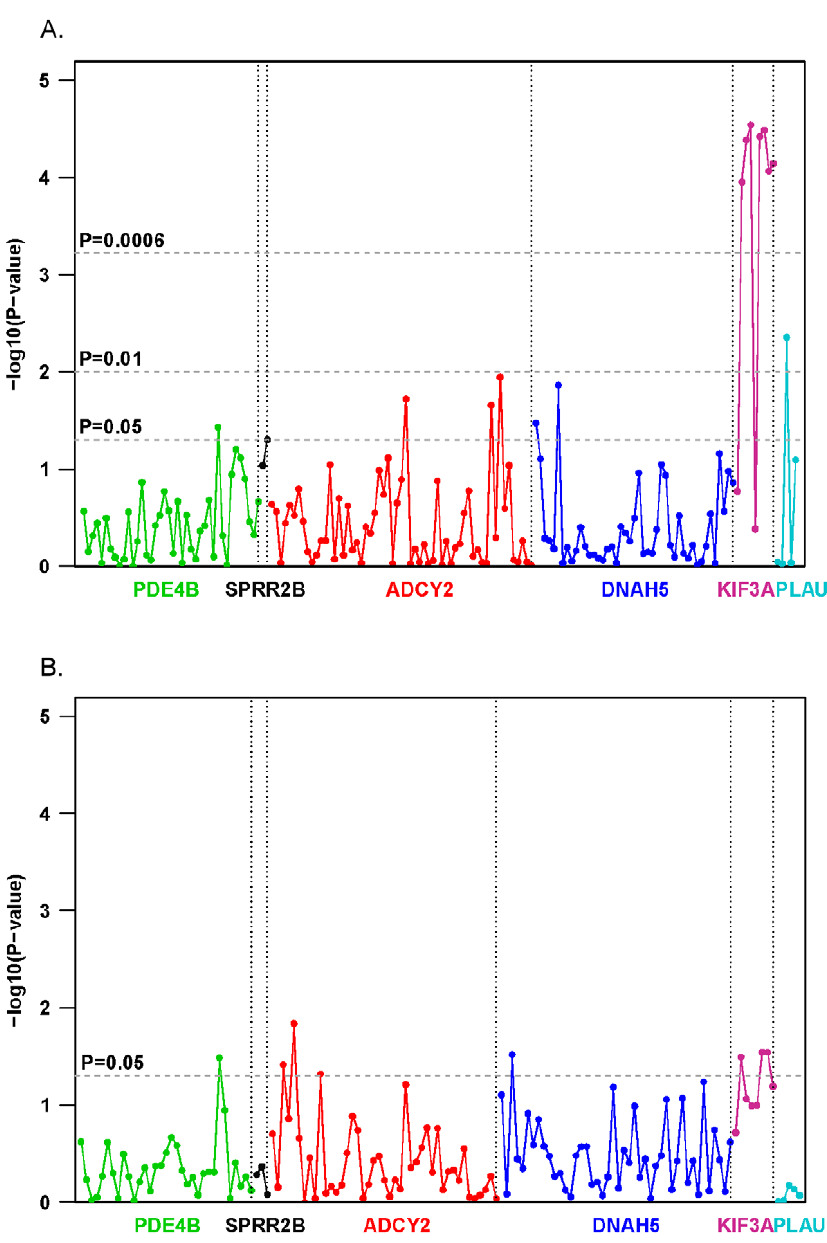
Figure 2. Genetic associations with childhood asthma. A . We evaluated associations in our discovery Caucasian population between asthma and 160 directly genotyped SNPs within the six epithelial genes using the additive model after adjusting for age and gender. The upper dashed line corresponds to a p-value of 0.0006, the Bonferroni adjustment after considering LD correlation between SNPs. SNPs significant at this level (all in KIF3A ) include rs12186803 (p=0.00011), rs3798130 (p=0.00004), rs2299011 (p=0.00003), rs12514685 (p=0.00004), rs7737031 (p=0.00003), rs1080001 (p=0.00009), and rs9784675 (p=0.00007). The lower dashed line corresponds to a p-value of 0.05. SNPs significant at this level include rs11747117 (p=0.0188), rs7714830 (p=0.0219), and rs13174121 (p=0.0113) in ADCY2 , rs2896111 (p=0.0335) and rs17263496 (p=0.0136) in DNAH5 , rs12060491 (p=0.0369) in PDE4B , rs6693927 (p=0.0496) in SPRR2B and rs2227562 (p=0.0044) in PLAU . B . Associations between asthma and 160 directly genotyped SNPs within the six epithelial genes were evaluated among African American children from Cincinnati using an additive model after adjusting for age and gender. The dashed line corresponds to a p-value of 0.05. SNPs significant at this level include rs11742602 (p=0.038), rs2017214 (p=0.014) and rs1032719 (p=0.048) in ADCY2 , rs30168 (p=0.030) in DNAH5 , rs11208834 (p=0.032) in PDE4B , rs12186803 (p=0.032), rs1080001 (p=0.029) and rs7737031 (p=0.028) in KIF3A .